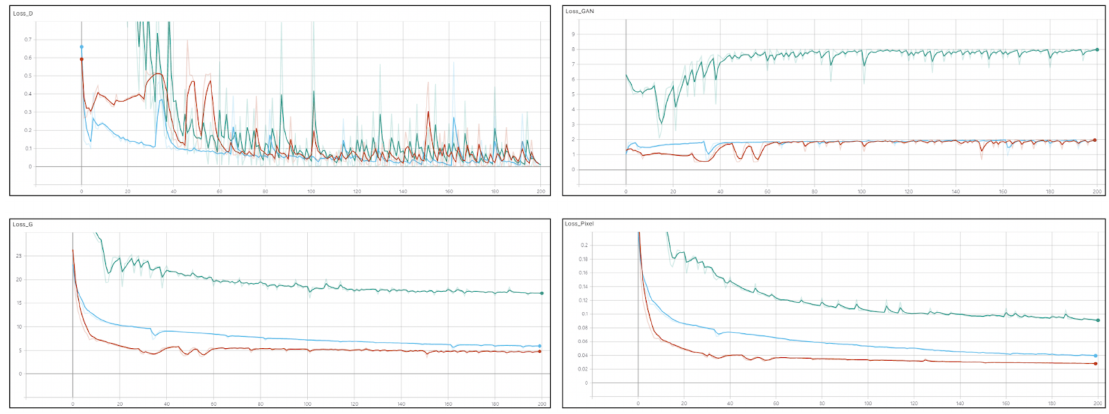
Figure 12. Variations in loss graph during training.